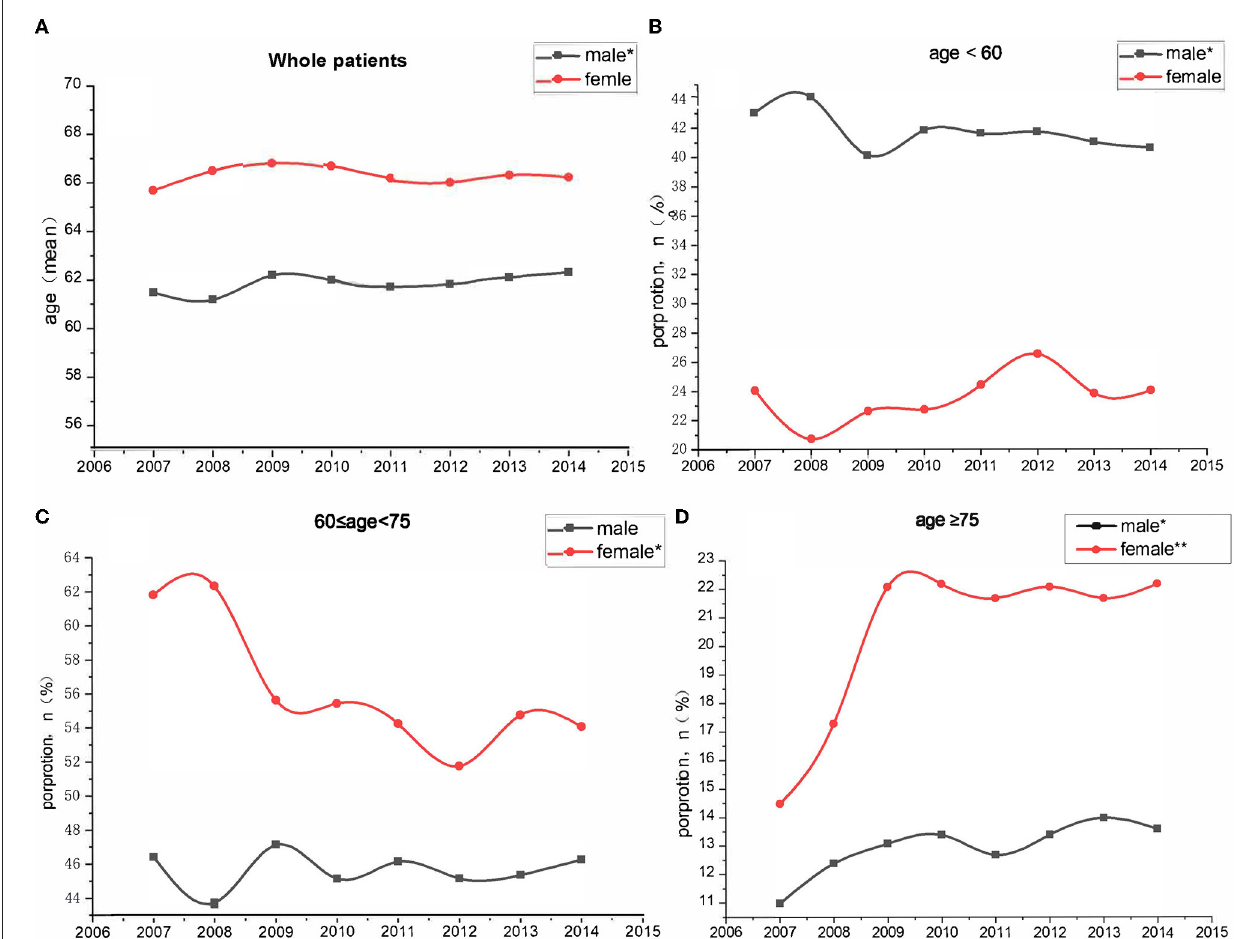
FIGURE 2 | Trends in proportion of different age group among patients with coronary artery disease between 2007 and 2014. (A) Whole patients; (B) age < 60-year group; (C) 60 ≤ age < 75-year group; (D) age ≥ 75-year group. * P < 0.05; ** P <